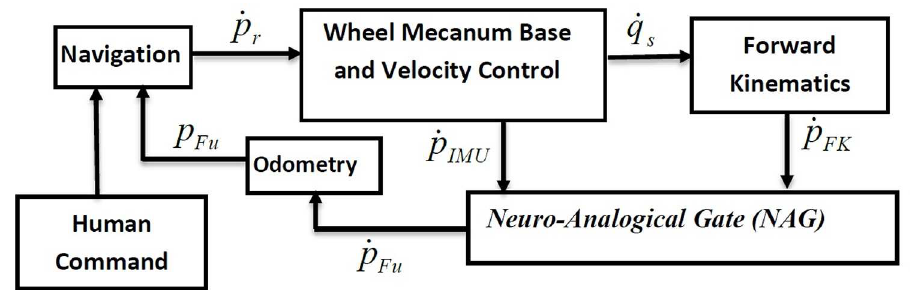
Fig 15. The apartment node